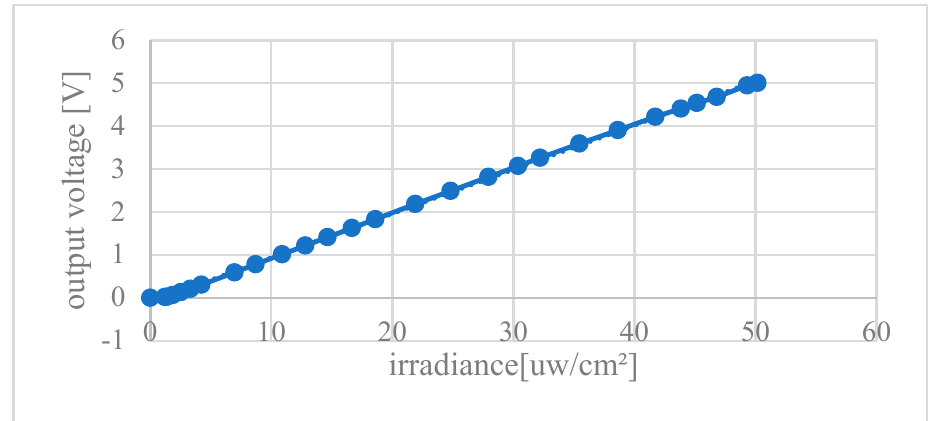
Figure 17. The curve of the output voltage versus LED irradiance. The projection system with a micromirror and a monolithic optoelectronic integrated sensor chip is shown in Figure 18.